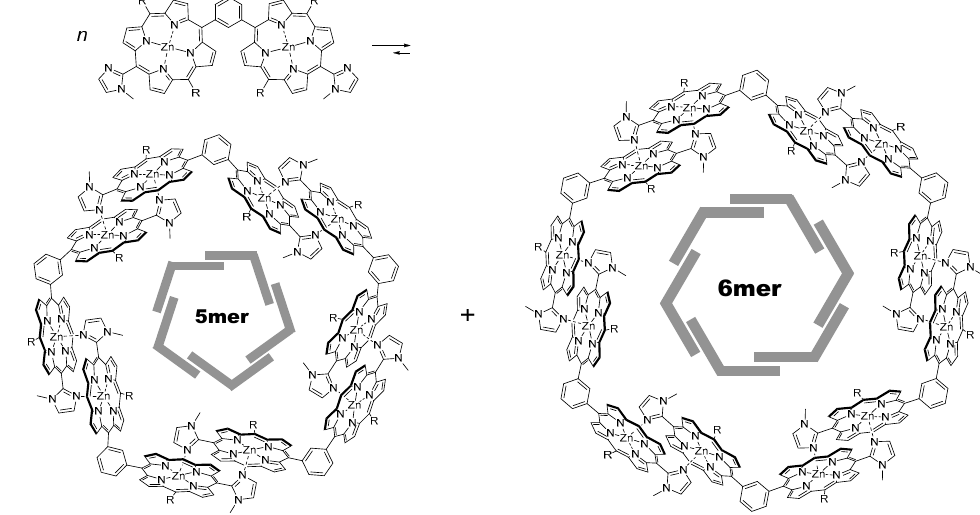
Figure 3. A Gable porphyrin (GP) and its self-assembled pentamer and hexamer.